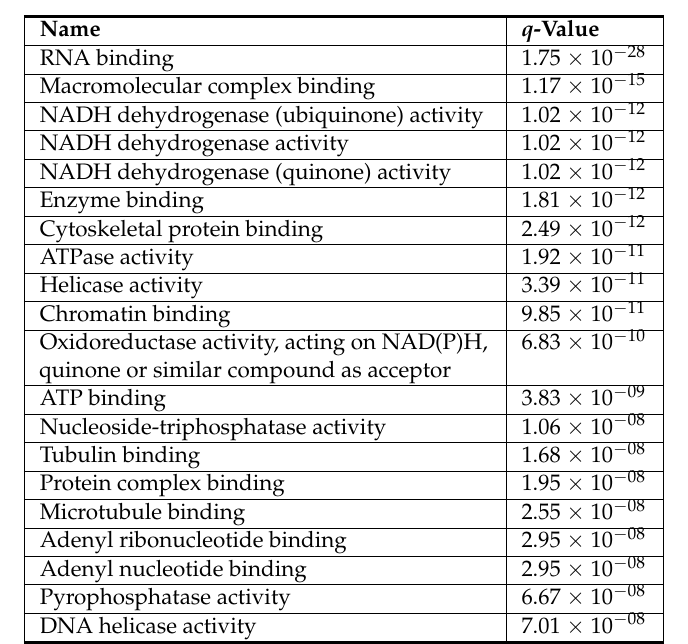
Table 4. ToppFun functional enrichment analysis—Molecular Function (MF). The top 20 significant MF terms are shown